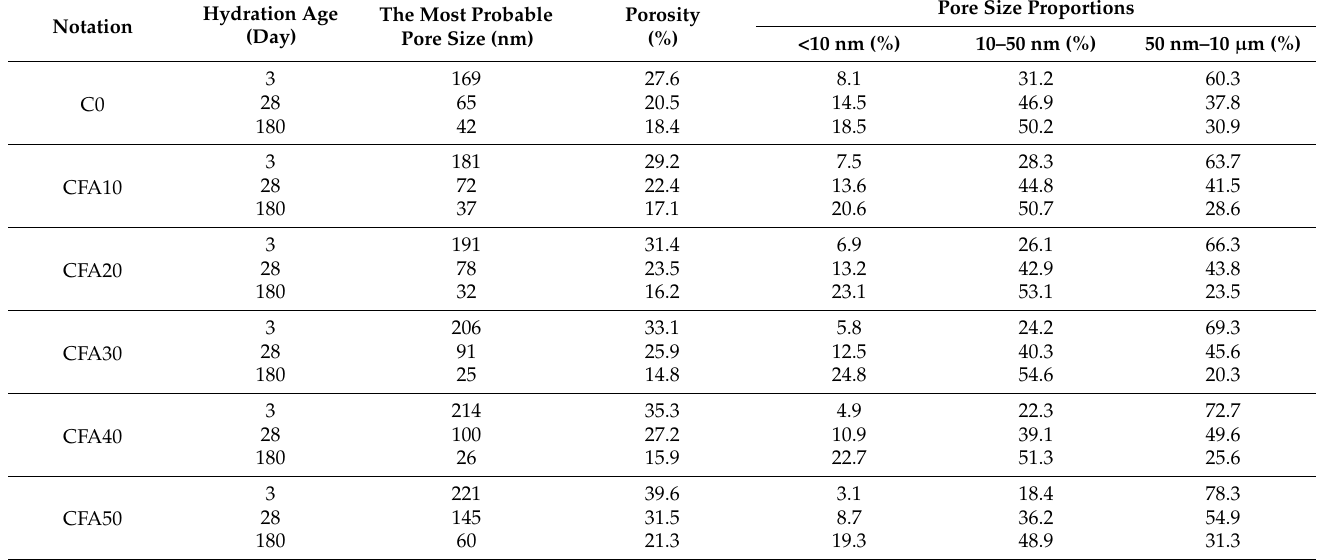
Table 4. Pore structure parameters of the face slab concretes containing different dosages of fly